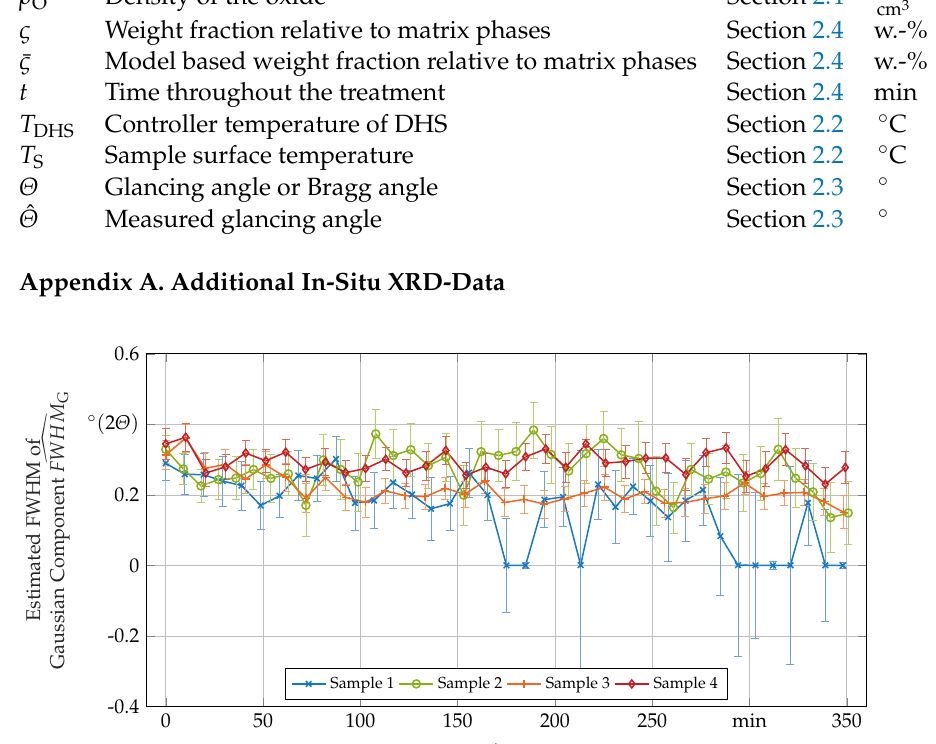
Figure A1. Estimated FWHM of the Gaussian component function fitted to the ( 002 ) - γ -peak over the time spent in the HT measured with in-situ XRD.